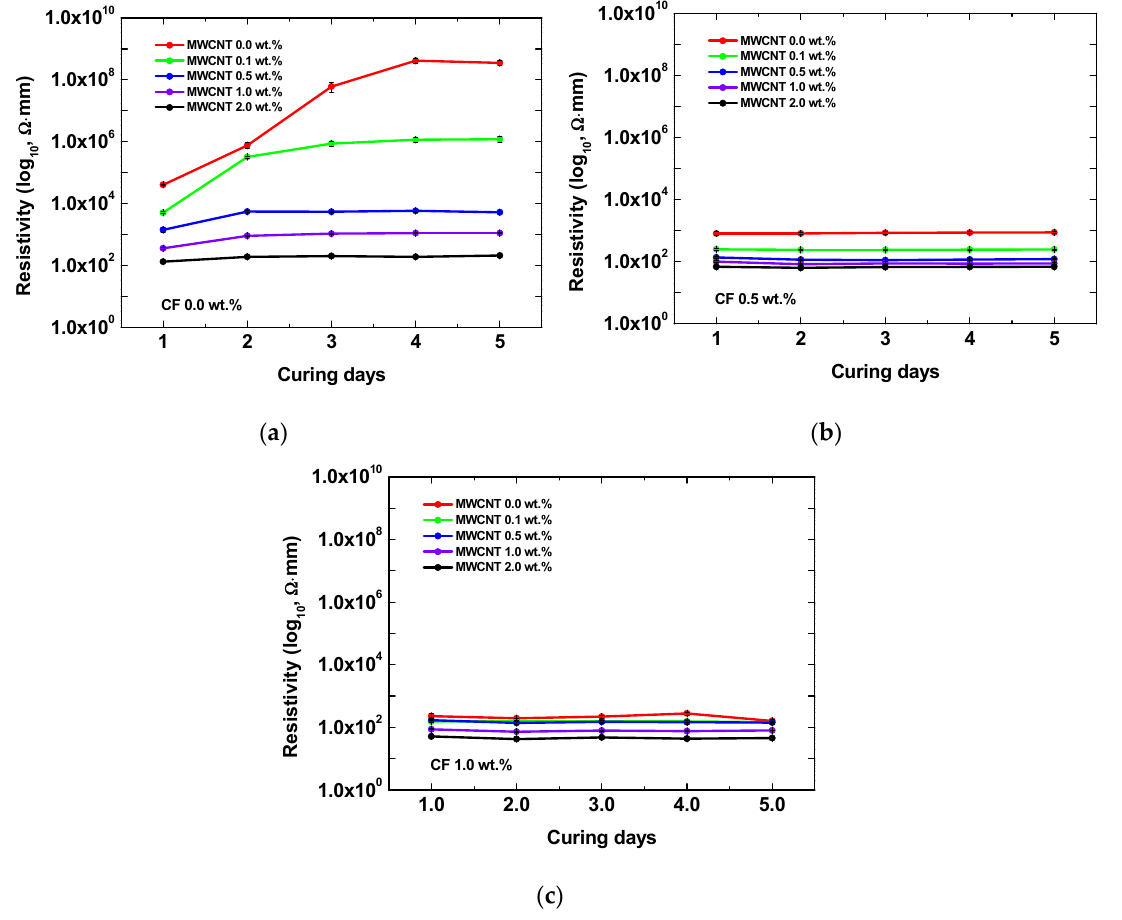
Figure 3. Electrical resistivity results of MWCNTs-incorporated AAS composites with ( a ) 0 wt.%, ( b ) 0.5 wt.%, and ( c ) 1.0 wt.% of CF according to the curing days.